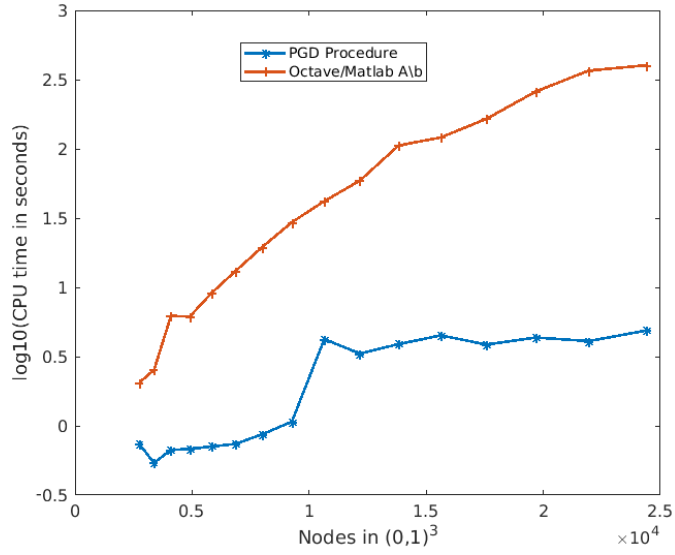
Figure 10. Comparison made in [37] in terms of CPU time between the PGD method and the tra- ditional A\b Matlab-Octave method for the resolution of the Poisson equation as a function of the number of nodes in the discretization of the